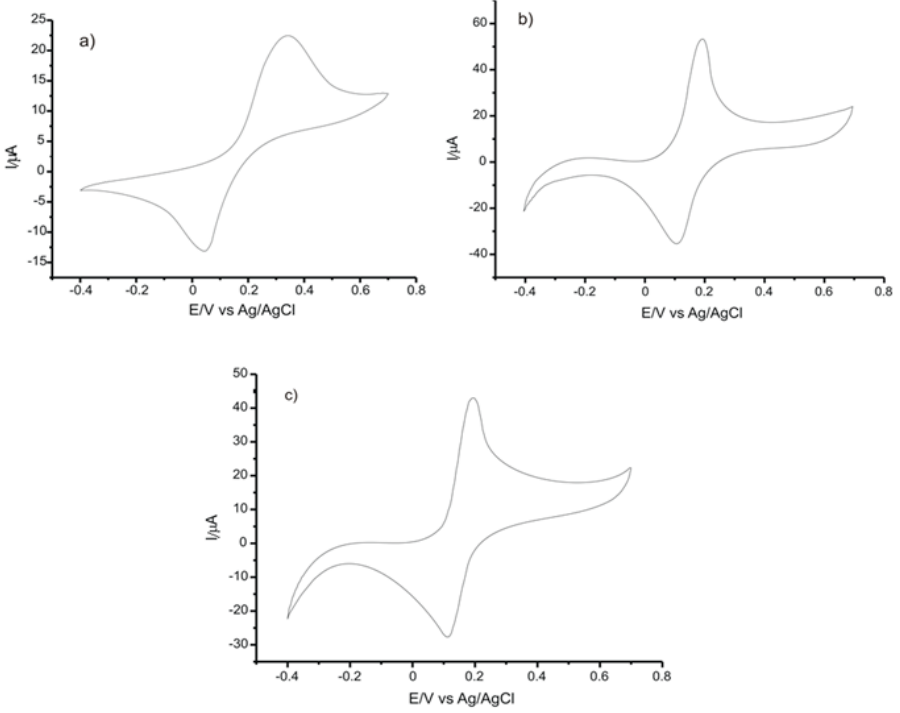
Figure 4. CVs of of ( a ) C-SPEs, ( b ) GPH-SPE, and ( c ) GPH-GNP-SPE immersed in 10 − 3 M CGA solution (support electrolyte 10 − 1 M PBS solution). Scan rate 0.1 V·s − 1 . The electrochemical electrooxidation of the CGA presupposes, initially, the pre-dis- sociation of a proton, with the formation of a monoanionic species. The latter is in turn oxidated to generate a radical. This radical formed is subjected to a new rapid electronic transfer, with the formation of a carbocation which, through dehydration, forms the re- spective quinone. During the reversed scanning, the quinone formed is reduced to CGA. The oxidation mechanism is presented in Figure 5.